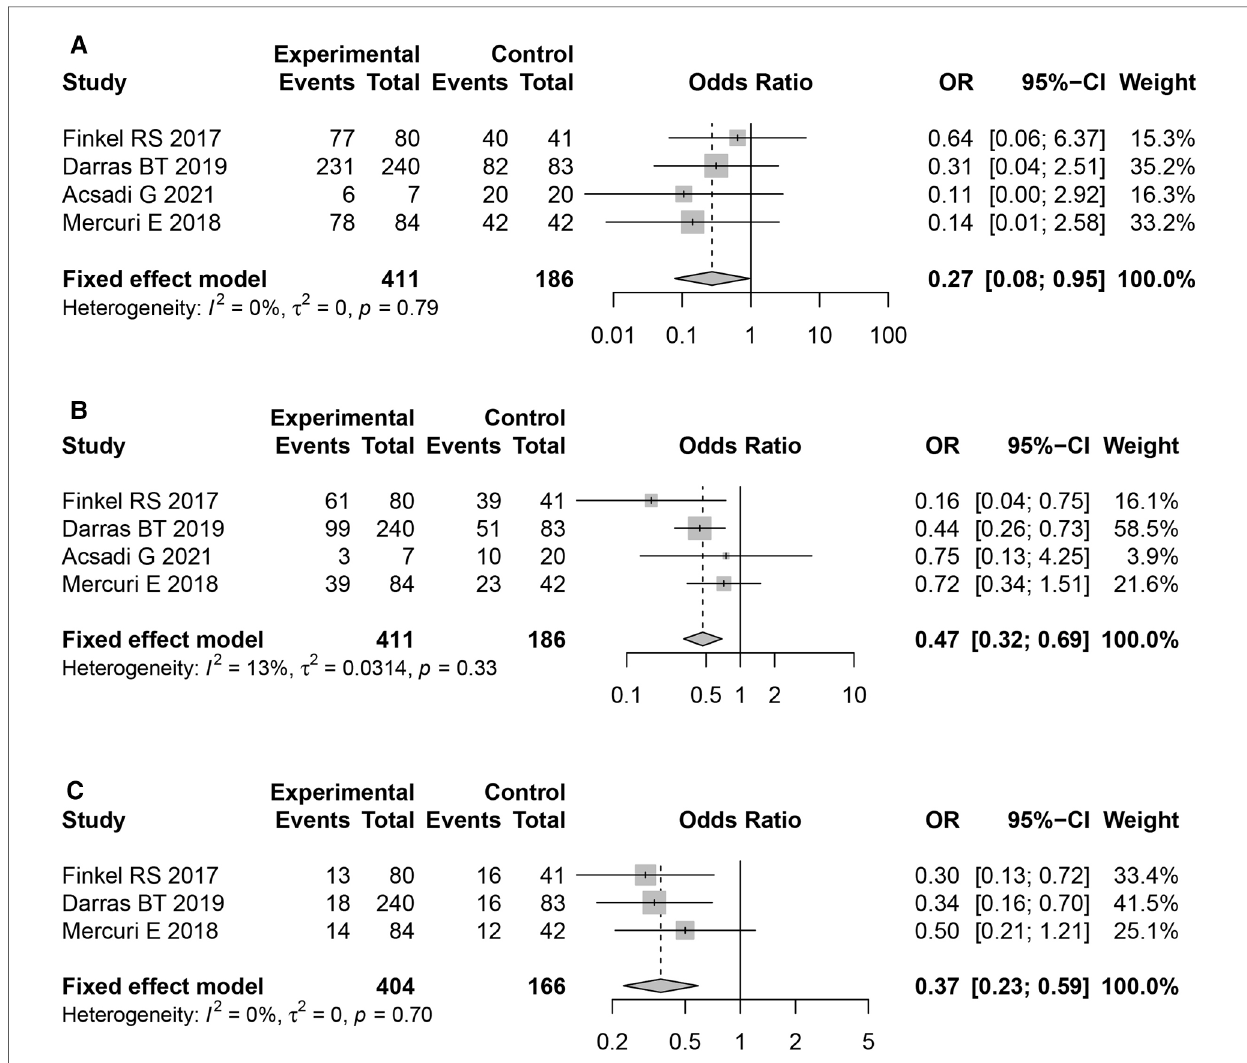
FIGURE 3 Forest plot of AEs in nusinersenand control